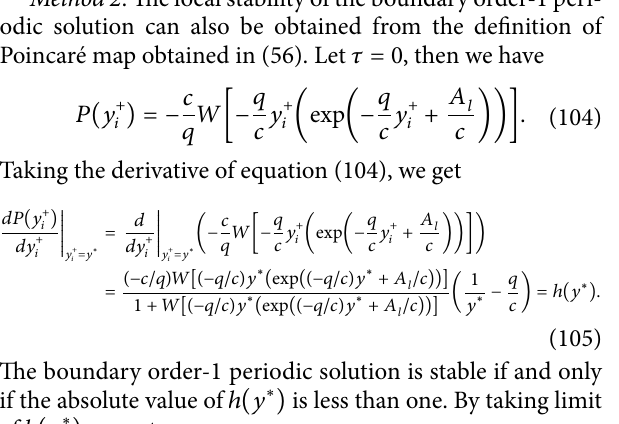
Figure 4: (a–c) Unstable boundary order-1 periodic solution with 퐿 2 = 퐴푇/ ( 훼 + 푐훽 ) = 3 , and boundary order-1 periodic solution with 퐿 2 = 2 퐴 𝑙 = −0.106676 퐴푇 = 2.16 , , , , , , , 훽 = 0.1 푝 = 0.8 훼 = 0.9 휏 = 0 휆 = 0.52 휔 = 0.1 푟 = 0.23 훿 = 0.3